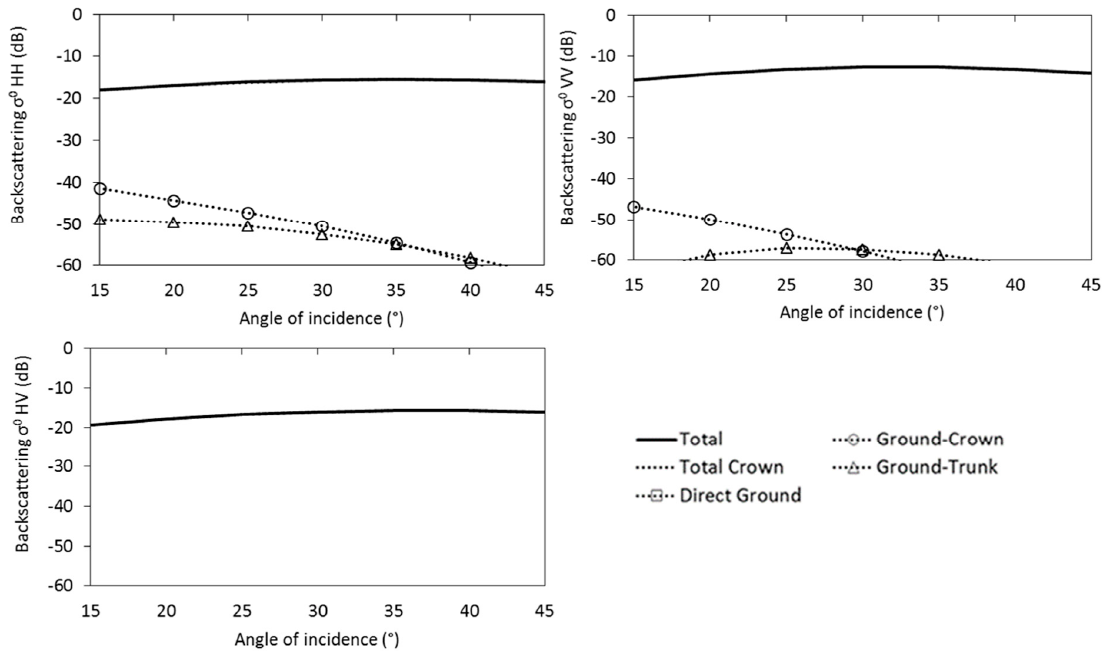
Figure A2. Total co-and cross-polarisations canopy backscatter components vs. scattering angle from needle-branch canopy layer 85,000 needles and 3.4 branch density Norway spruce for S-band.